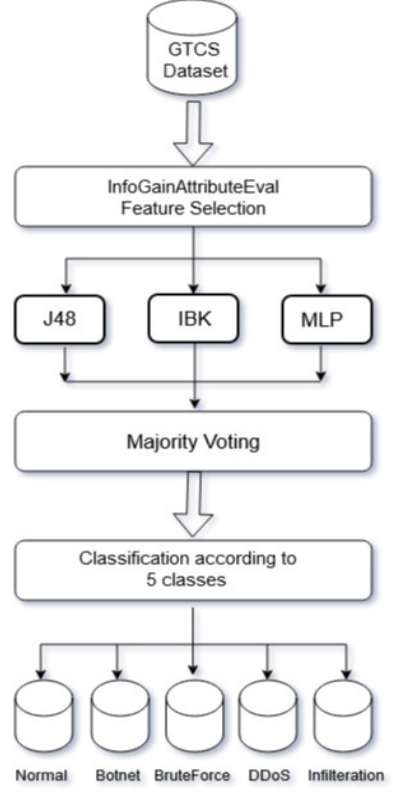
Figure 5. Ensemble classifier model flow.